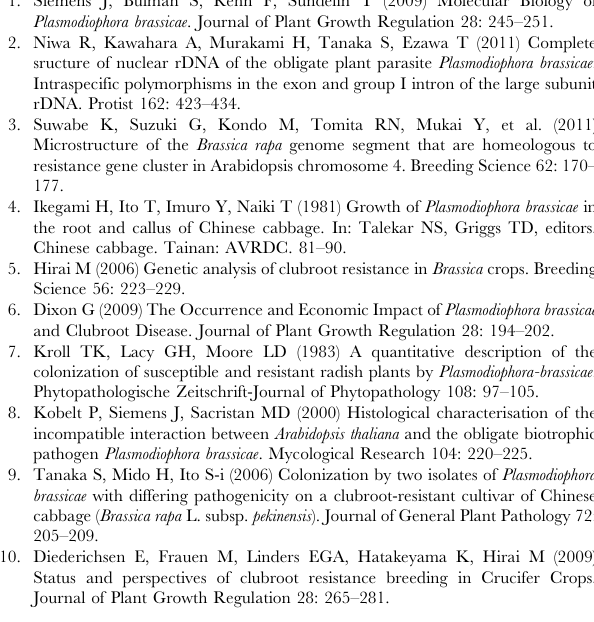
Figure S4 Typical root symptoms of transgenic Brassica rapa inoculated with Ano-01. Resistance responses were evaluated 5 weeks after inoculation. Root symptoms were graded as: 0, no symptoms; 1, very slight swelling on main roots; 2, a small gall on main roots; 2.5, moderate swelling on main roots; 3, severe swelling on main roots. Scale bar indicates 5.0 cm. Figure S5 Typical root symptoms of Arabidopsis (Col-0) inoculated with P. brassicae . Resistance responses were evaluated 3 weeks after inoculation. Root symptoms were graded as: 0, no symptoms; 1, very slight swelling on lateral roots; 2, moderate swelling on lateral roots and taproot; 2.5, severe swelling on all roots but no swelling on hypocotyl; 3, severe swelling on all roots and hypocotyl. Scale bar indicates 1.0 cm. Table S1 Sequences of primers used in this